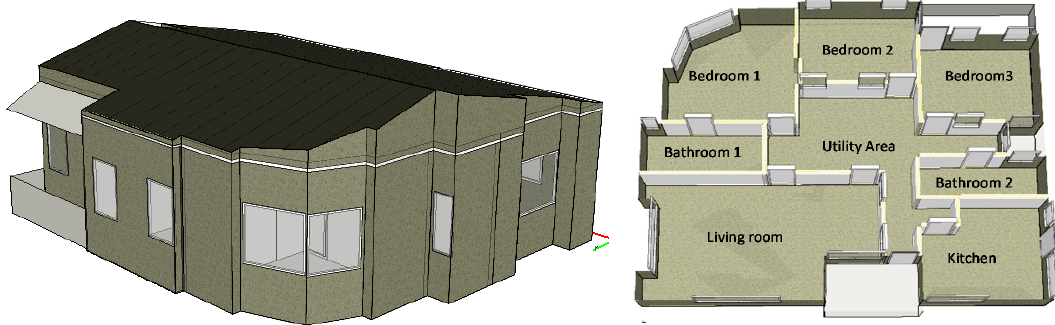
Figure 4. Illustration from the north-east direction and layout of the analyzed building in Kumasi, Ghana. Table 4. Key architectural and design characteristics of the second single-family house, in Kumasi.